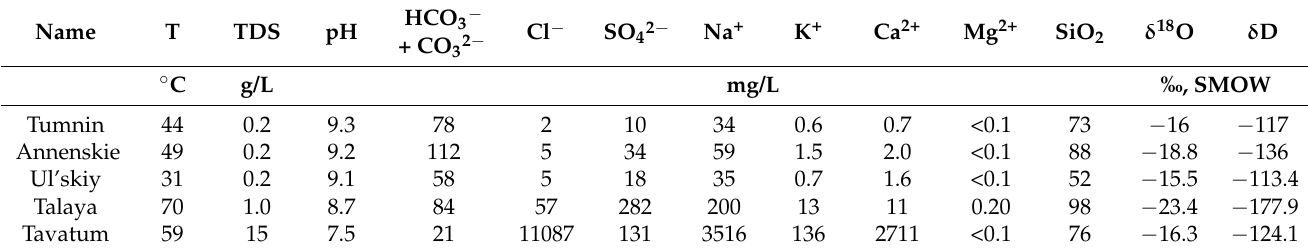
Table 1. Chemical composition of the Okhotsk Sea Coast thermal